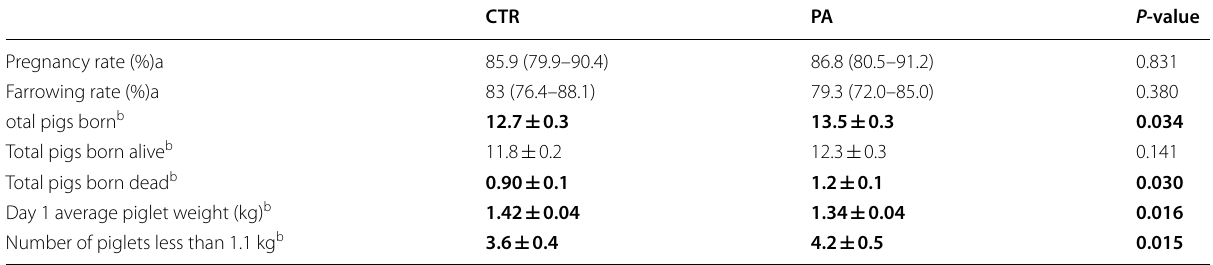
Table 1 Reproductive performance of sows fed a control diet (CTR) or the control diet supplemented with a PA during the gestation period